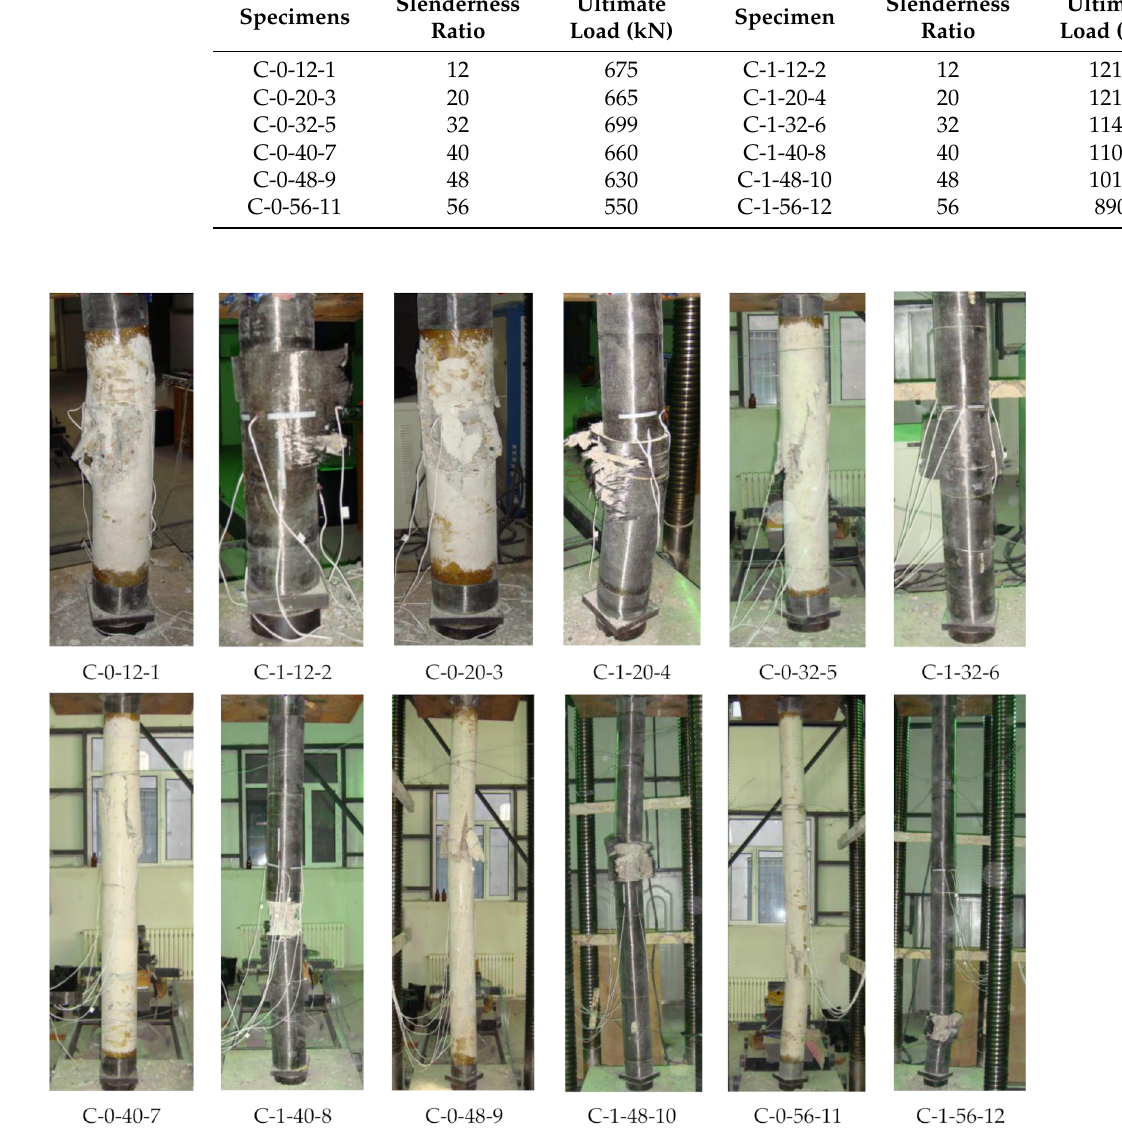
Figure 2. Failure mode of tested